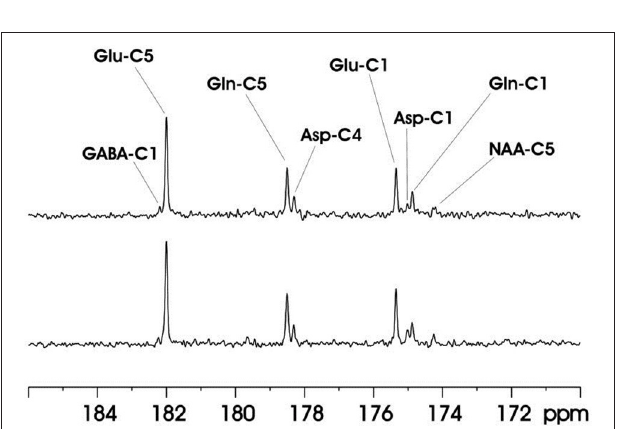
FIGURE 10 | In vivo 13 C MRS spectra acquired from the rat brain at 11.7 Tesla using Ernst’s stochastic decoupling sequence (top trace) and using the windowed stochastic decoupling sequence (bottom trace). In both acquisition intravenous infusion of [2,5- 13 C 2 ] glucose were used. The peak RF amplitude of the windowed stochastic decoupling sequence is 707 Hz with decoupling power at 51.4% of that used in the original pseudo-stochastic decoupling sequence. Acquisition parameters were: SW 10 kHz, acquisition time 204.8 ms, TR 2s, TE 18 ms. Adapted from Xiang et al. [34].